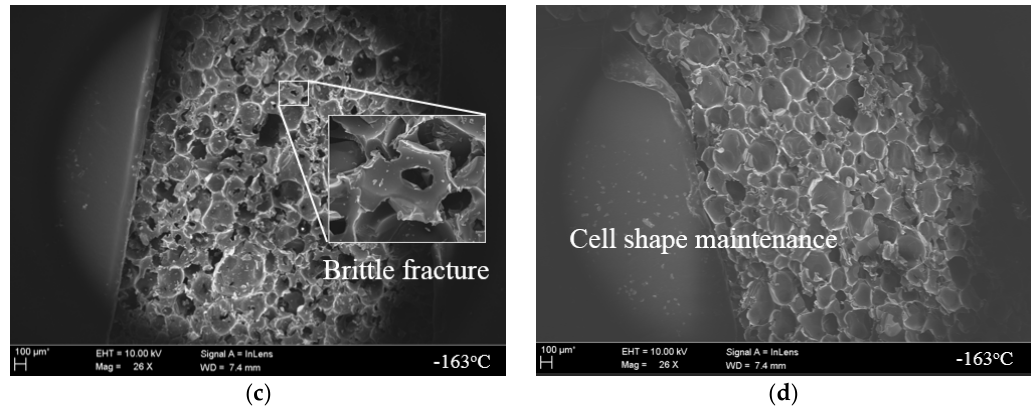
Figure 12. Microstructure inside the pure PUF after the compressive tests according to the restraint condition. ( a ) non-restraint at 25 °C; ( b ) restraint at 25 °C; ( c ) non-restraint at −163 °C; ( d ) restraint at